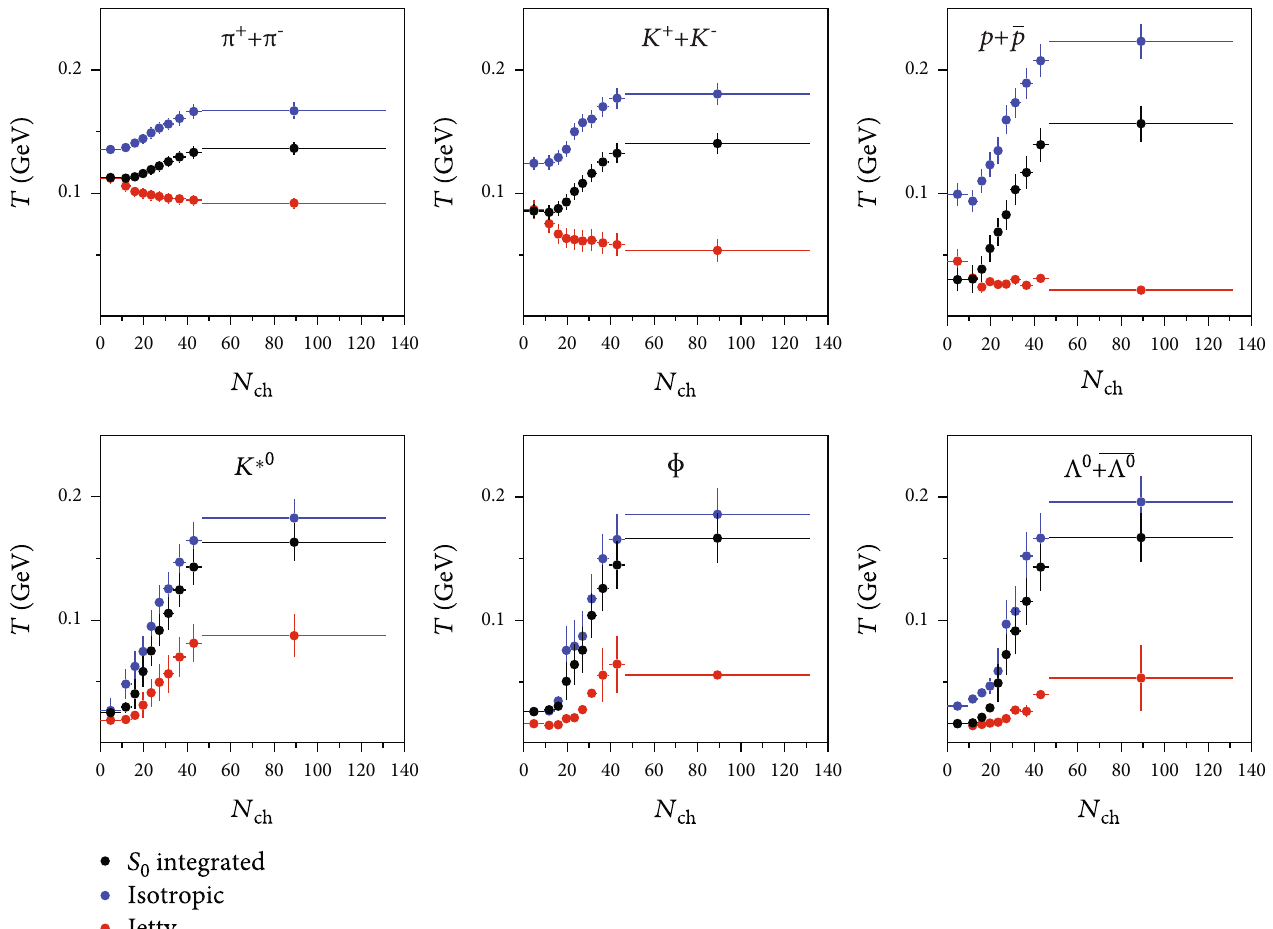
Figure 8: (Color online) Multiplicity dependence of T in di ff erent spherocity classes from the fi tting of Tsallis distribution using Eq.